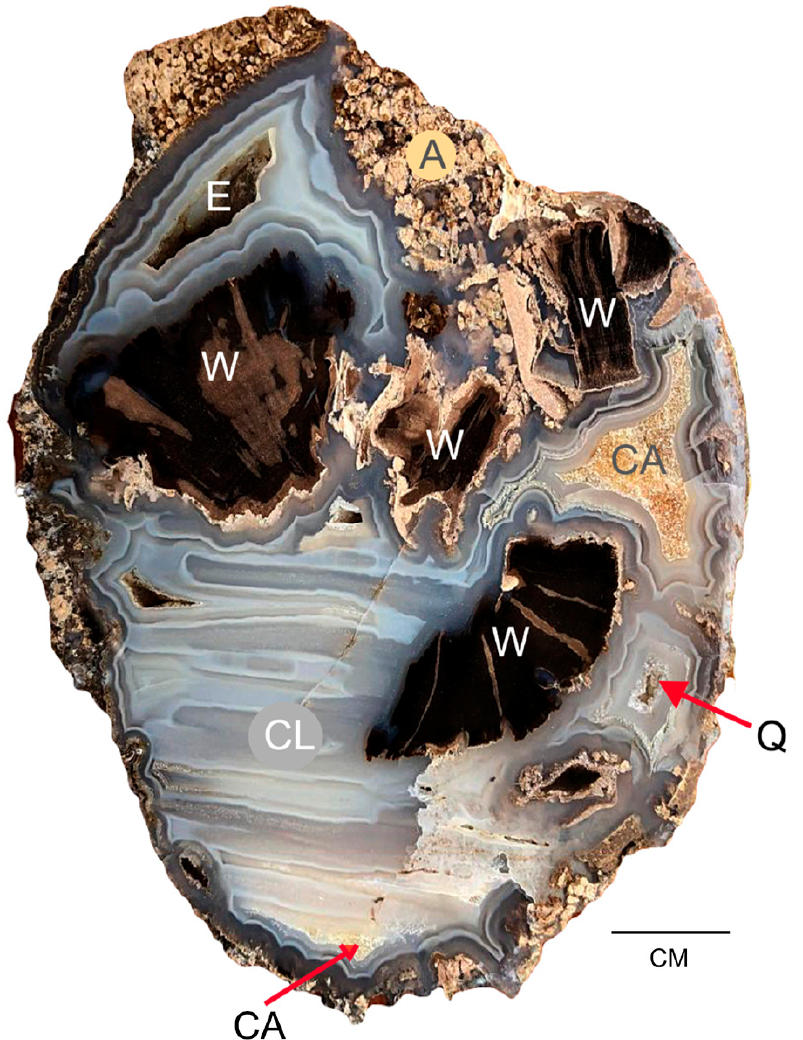
Figure 25. Blue Forest slab containing multiple mineral phases. A = algal coating; CA = calcite; CL = chalcedony; E = empty space; W = silicified wood; Q = quartz.